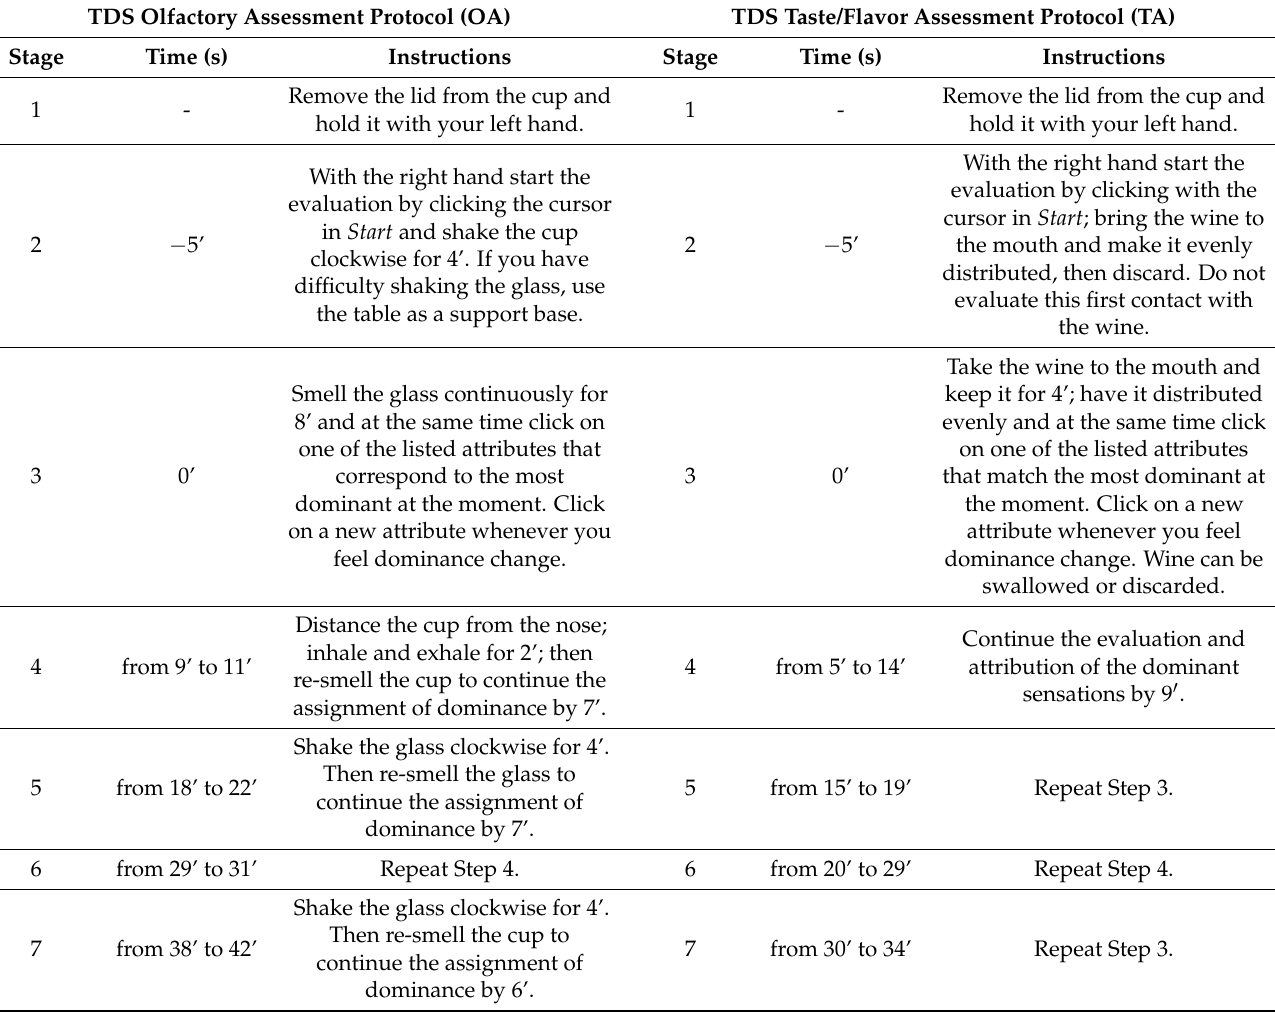
Table 5. TDS assessment protocol. Adapted from Pessina [31]. TDS Olfactory Assessment Protocol